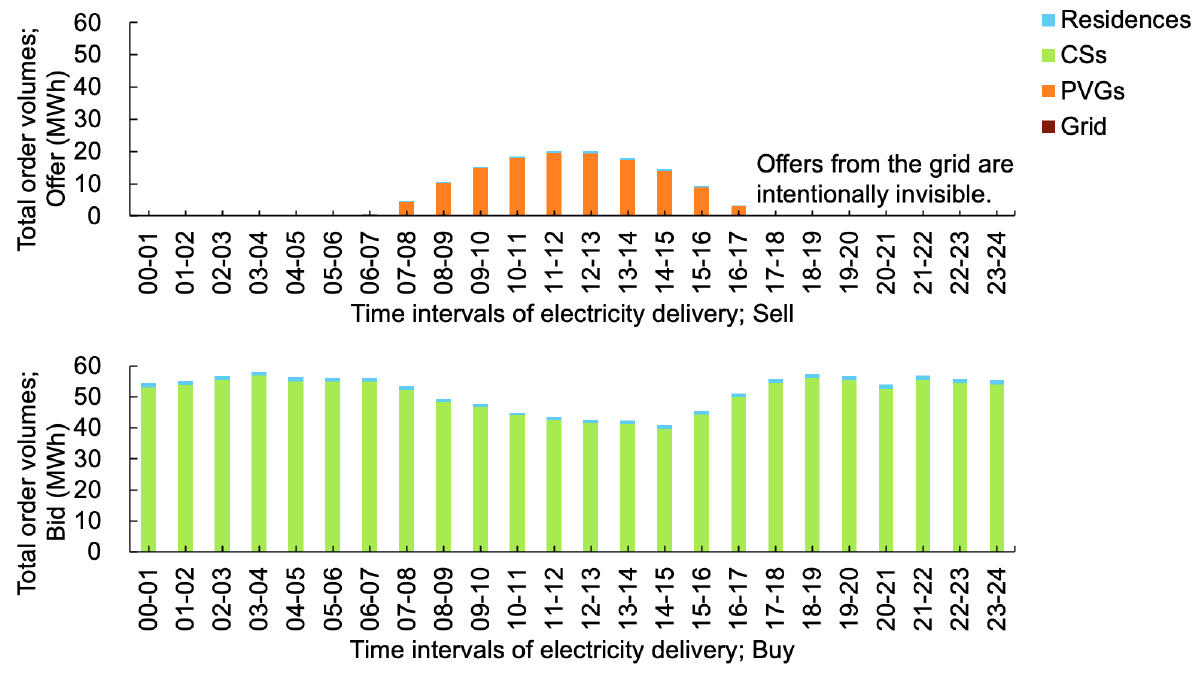
Figure 10. Total order volumes for each time interval in the target period.